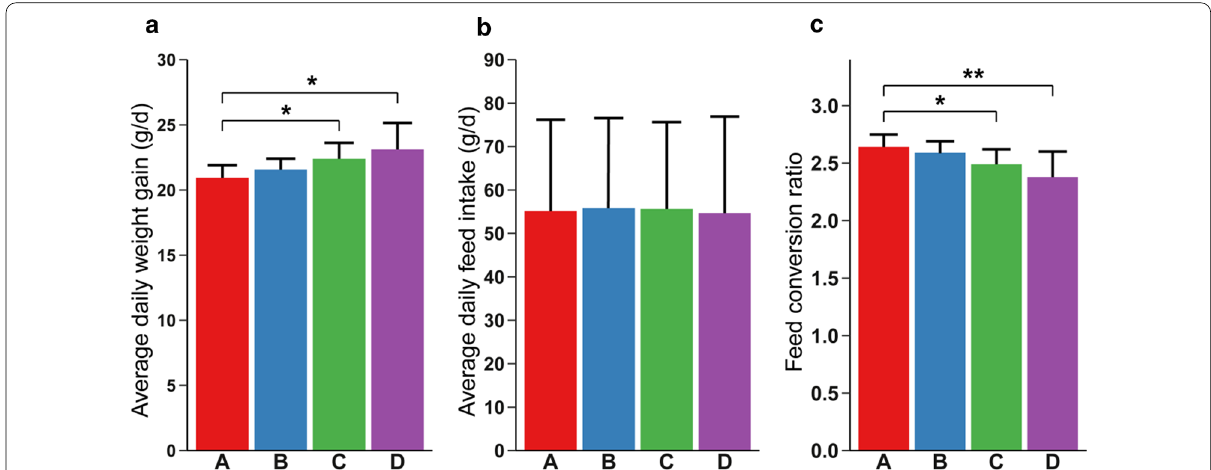
Fig. 1 Effects of different levels of purslane on growth performance of broilers. A, B, C and D correspond to the four treatment groups with 0%, 1%, 2% and 3% purslane, respectively. Average daily weight gain ( a ), average daily feed intake ( b ) and feed conversion ratio ( c ) were compared among the four treatment groups. Asterisk indicates significantly changed (p < 0.05), double asterisk indicates extremely significantly changed (p < 0.01)